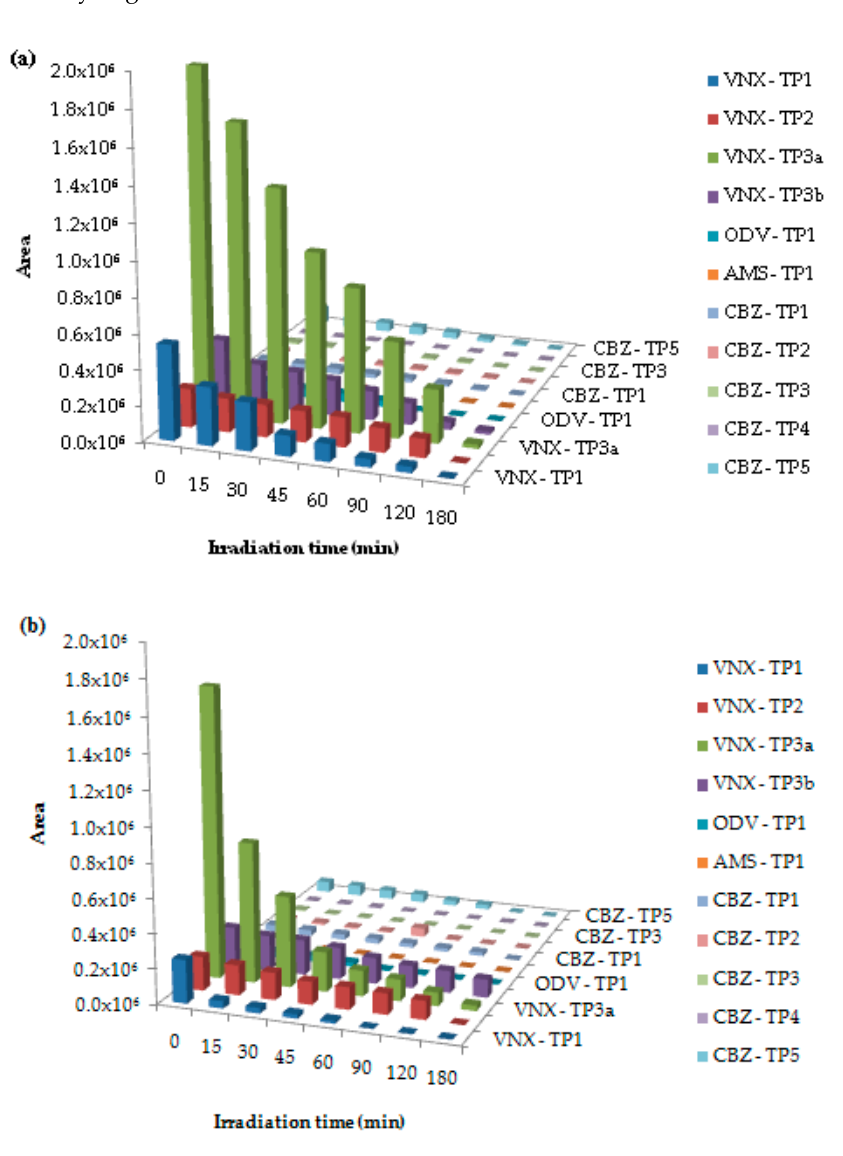
Figure 3. Evolution of identified metabolites/TPs in ( a ) TiO 2 and ( b ) CN photocatalytic treatment based on UHPLC-Orbitrap MS.